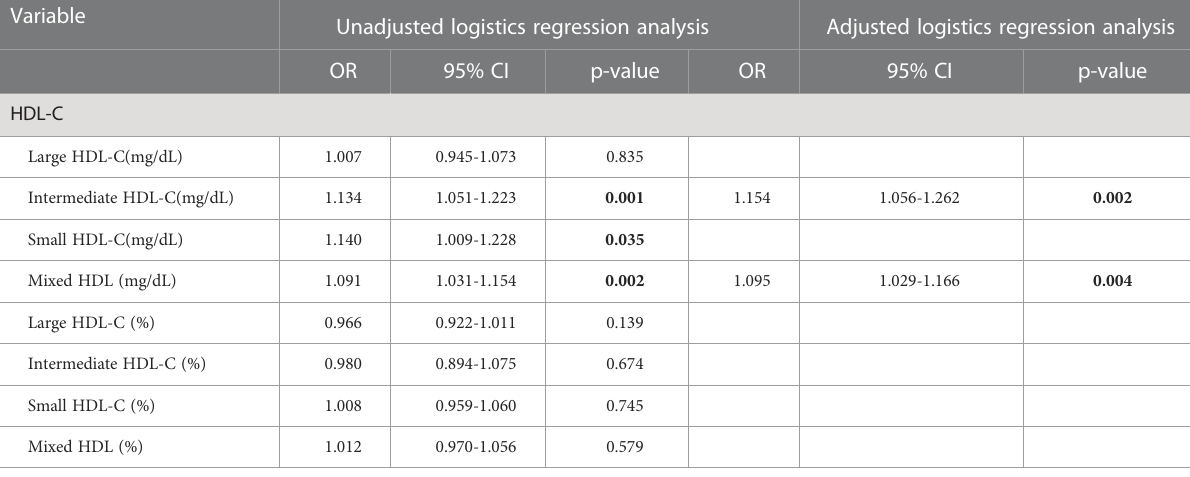
TABLE 4 Associations of HDL subfractions with CVEs in T2DM and SCAD